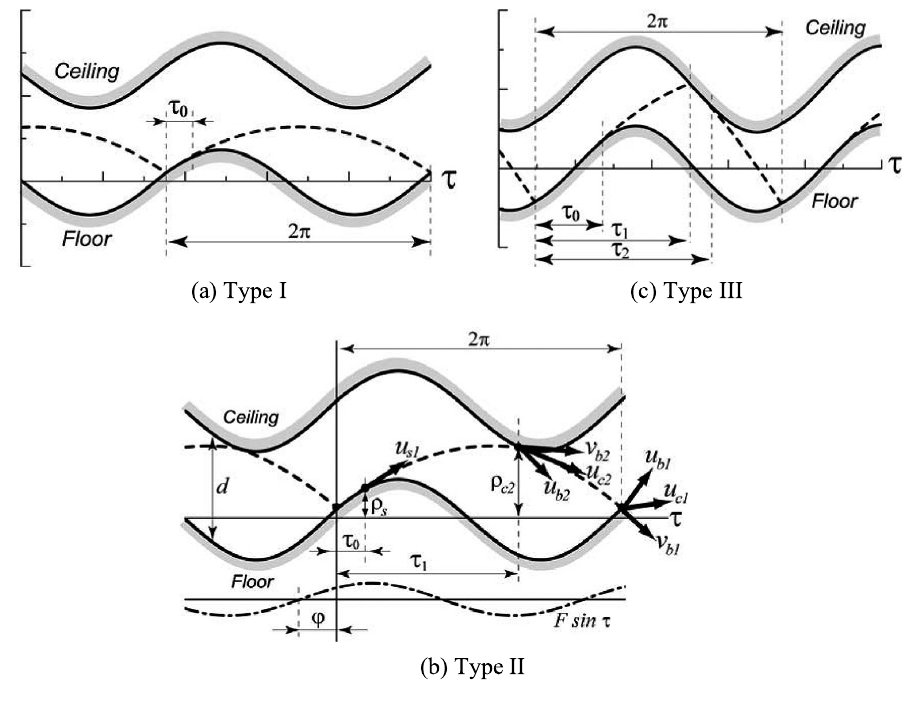
Fig. 3. Type of vibration of SDOF system with particle